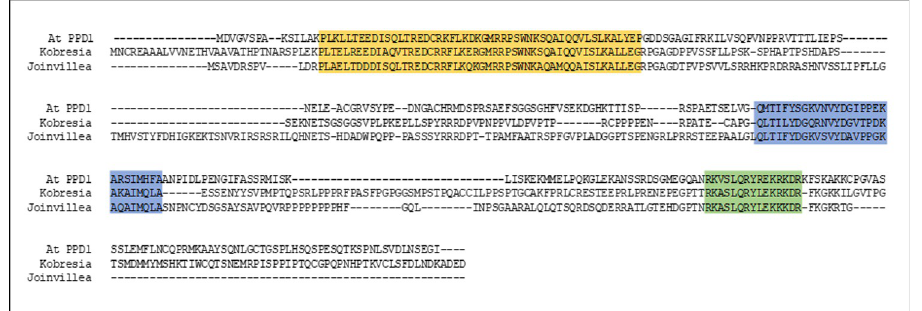
Fig 6. Alignment of Arabidopsis PPD1 with putative Kobresia and Joinvillea PPD proteins. The alignment shows the conserved PPD (yellow), TIFY (blue) and Jas � (green) domains.